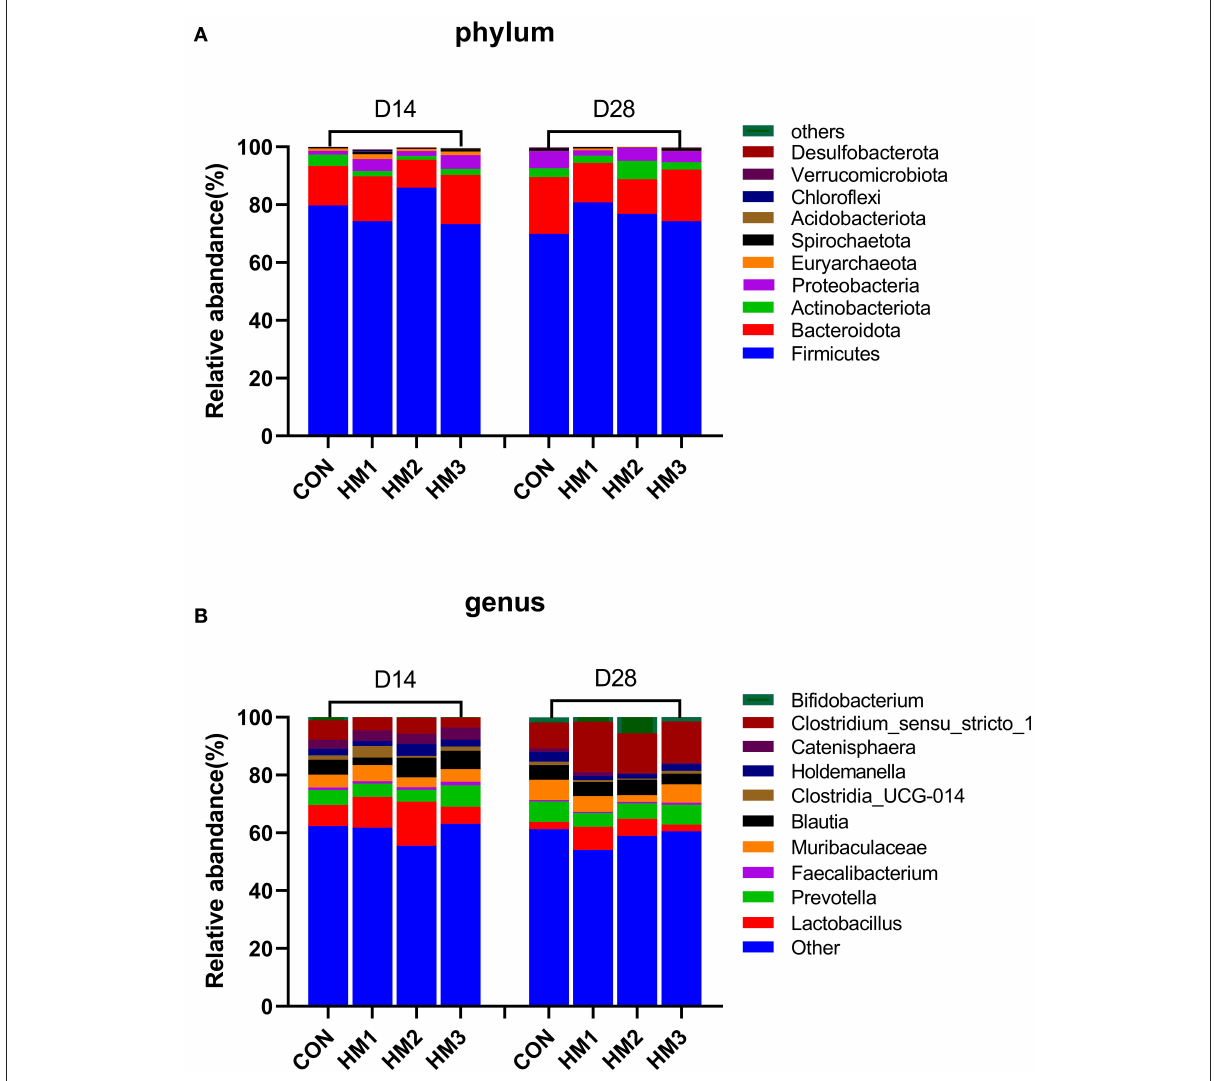
FIGURE2 Intestinal microbiota compositions of different groups at phylum (A) and genus (B) levels on days 14 and 28. CON, basic diet; HM1, basic diet with 0.5 g/kg of herbal mixture; HM2, basic diet with 1.0 g/kg of herbal mixture; HM3, basic diet with 1.5 g/kg of herbal